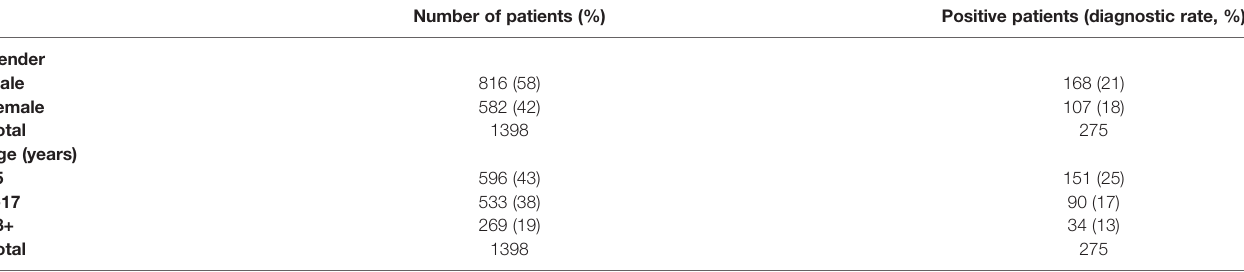
TABLE 3 | Cohort demographics of the Jeffrey ’ s Insights Program.